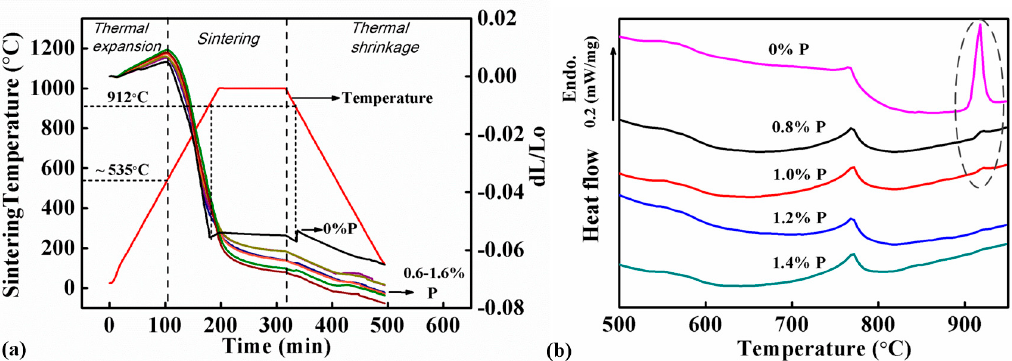
Figure 4. Analysis results: ( a ) Dilatometer (DIL) curves of samples with different P contents and the corresponding temperature profile, which indicate that the sintering of the Fe-0%P sample was interrupted at 912 ◦ C, but the Fe-0.6–1.6%P samples shrank continuously during sintering, and ( b ) differential scanning calorimetry (DSC) curves of samples with different P contents scanned from RT (room temperature) to 950 ◦ C at a heating rate of 15 ◦ C/min, which reveal an endothermic peak at 912 ◦ C corresponding to the ferrite-austenite reaction in the Fe-0%P sample. The endothermic peak became smaller or disappeared completely in all the P-containing samples.